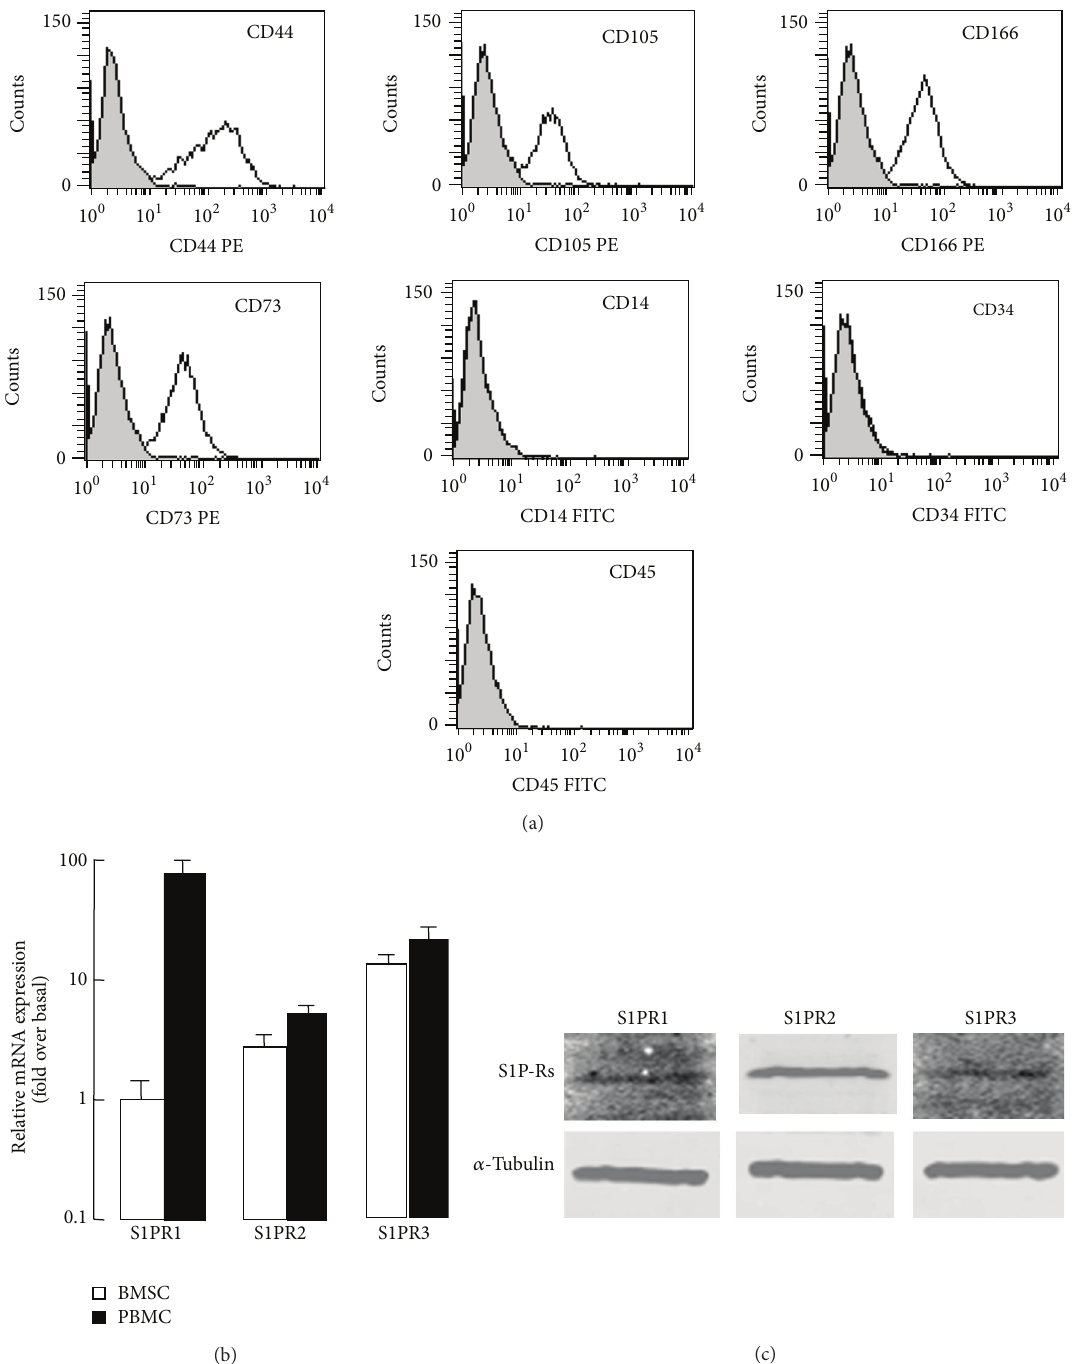
Figure 1: Expression of S1PRs in BMSCs. (a) The identification of BMSCs was performed by flow cytometry analysis. (b) Real-time PCR analysis for expression of S1PR1–3 in BMSCs. Human PBMCs as a positive control. (c) Western blot analysis for expression of S1PR1–3 in